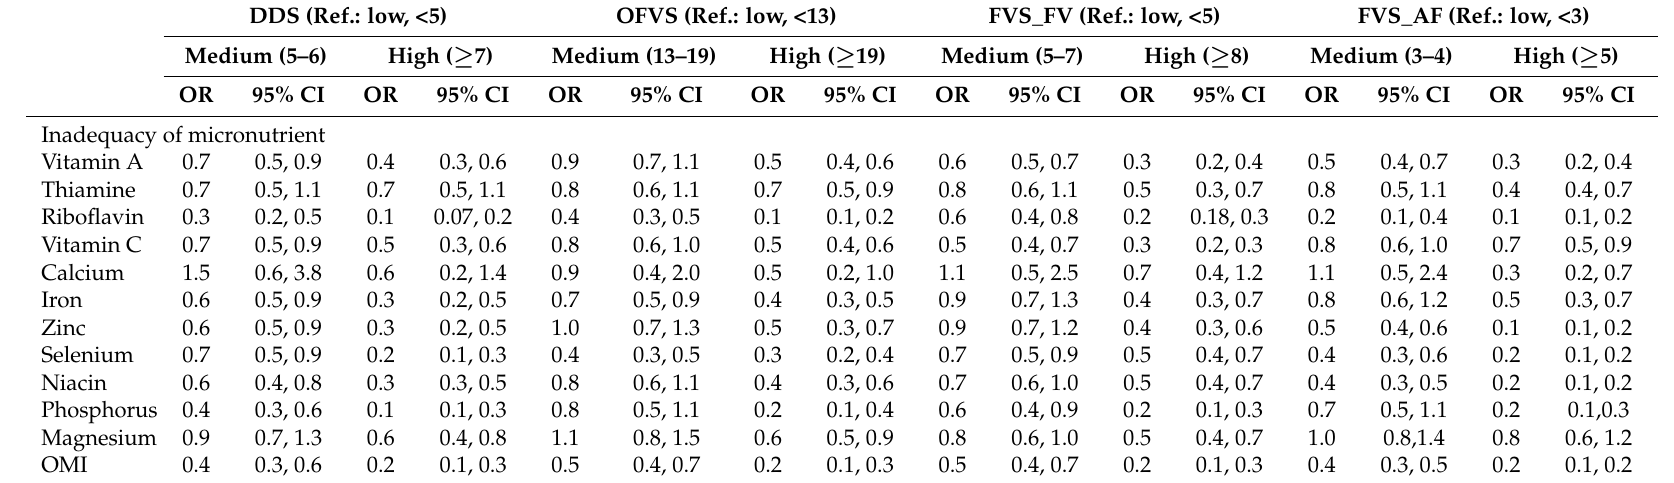
Table 4. Association of dietary diversity and food variety with micronutrient inadequacy †† ( n =